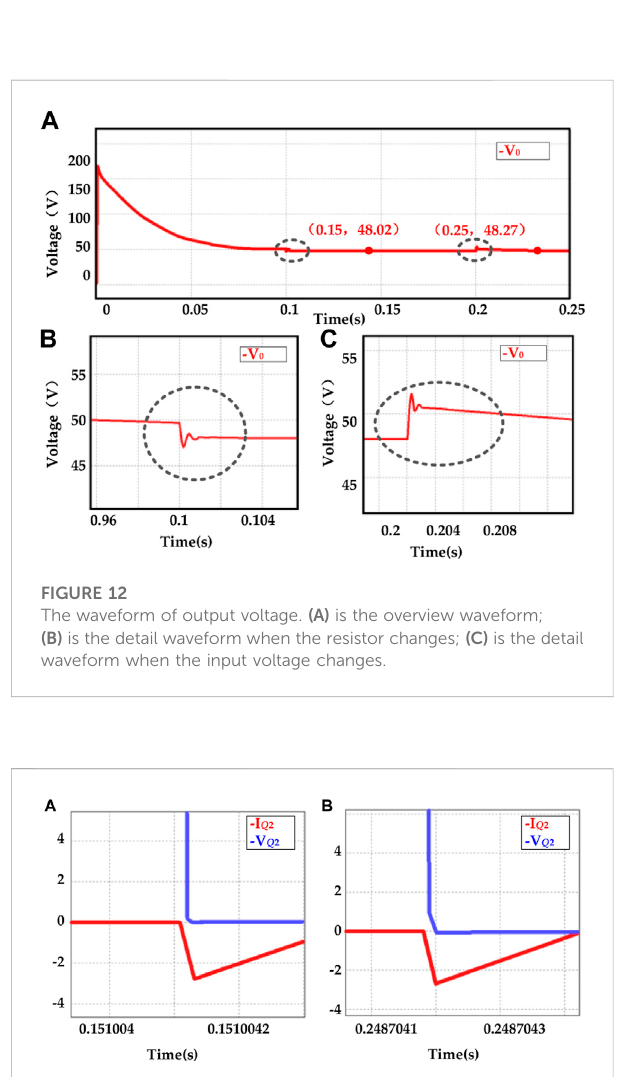
FIGURE 13 (A,B) are the waveform diagram of the current and voltage of Q 2 when the output voltage is stable, respectively.